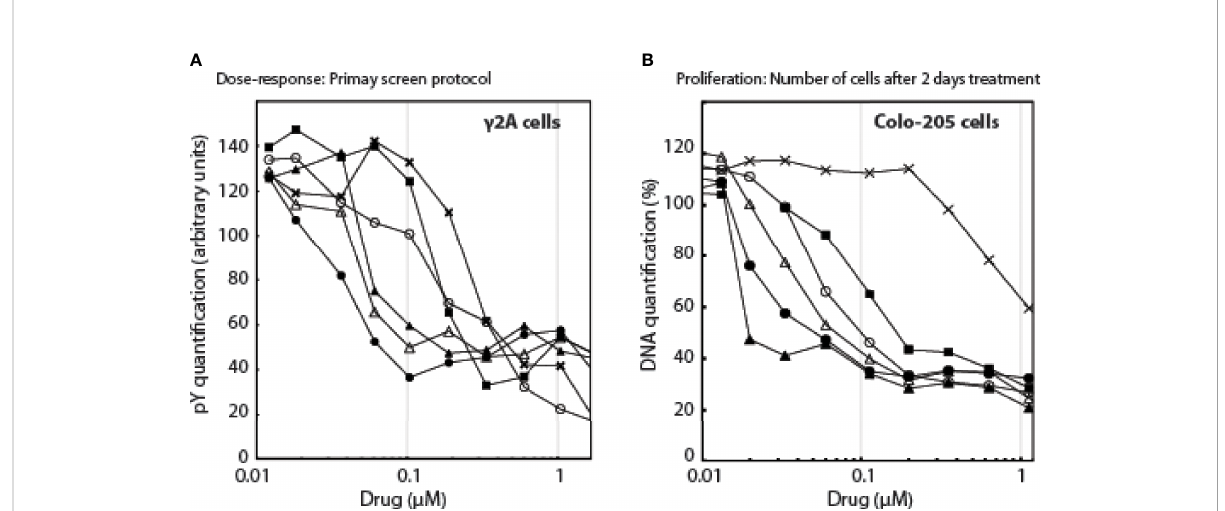
FIGURE 5 The effect of the drugs as a function of drug concentrations, (A) : on pY signals, (B) : on the number of cells. L , BM001; p , BM002; D , BM003; n , BM004; X, BM005; ○ ,